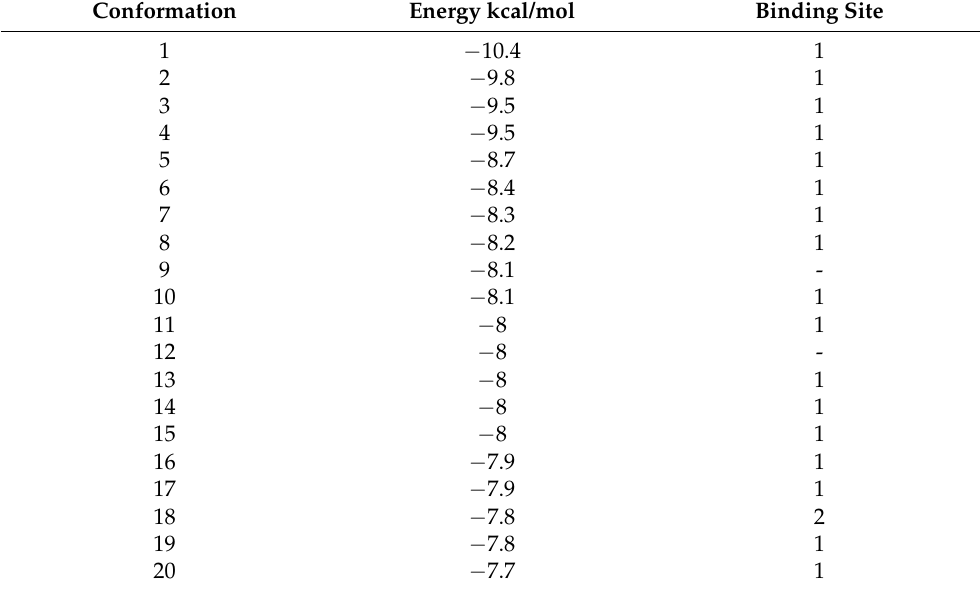
Figure 7. β-caryophyllene effect on P2X7R function and inflammatory response. ( A ) LDH release quantification after the stimulus with crescent β-caryophyllene concentrations for 24 and 72 h; ( B ) The graph represents the quantification of dye uptake assays performed to 37 ºC on MPM. Dose- response curves of β-caryophyllene concentrations with or without 1 mM ATP for 25 min analyzed, by fluorescence plate reader, to detect the PI uptake; ( C ) Dose–response curves of β-caryophyllene with or without 1 mM ATP for 25 min analyzed by fluorescence plate reader to detect the PI uptake; ( D ) total leukocytes, ( E ) mononuclear cells, ( F ) neutrophils, and ( G ) IL-1β per pool of peritoneal cavity of Swiss webster mice orally pretreated (1 h) with β-caryophyllene (1, 0.1, and 0.01 mg/kg),